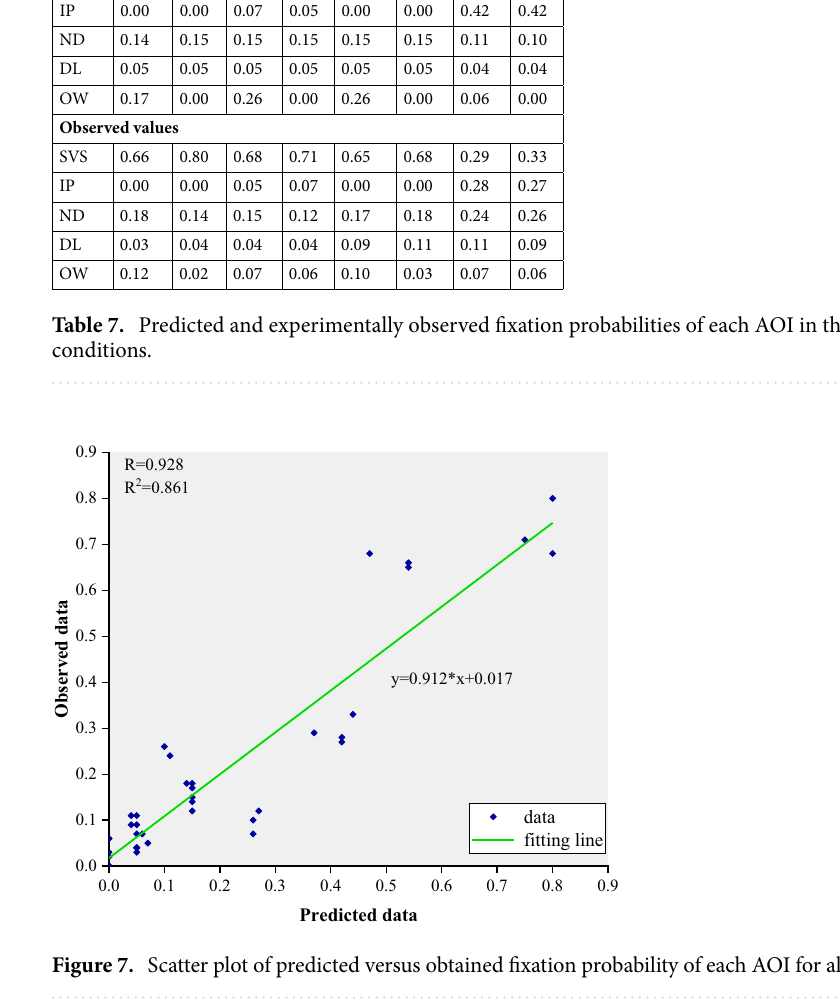
indicates not. The red symbol means the information in that AOI has updated, while the black symbol means not. The delay time for establishing SA corresponding to one AOI can be predicted by the number of consecutive “ ⨯ ”. Taking the sub-fragment framed in blue in Fig. 6 as an example, it indicates information in ND updated in